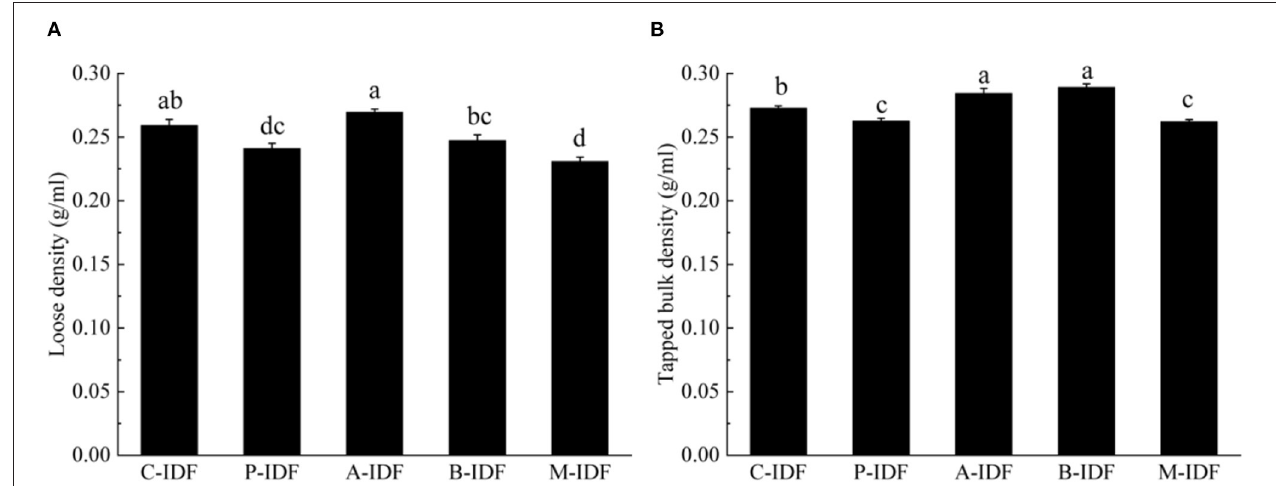
FIGURE 3 | Density of W-IDF. (A) Loose density (LD), (B) tapped bulk density (TBD). Data were expressed as means ± SD with different letters representing significant difference ( p < 0.05).